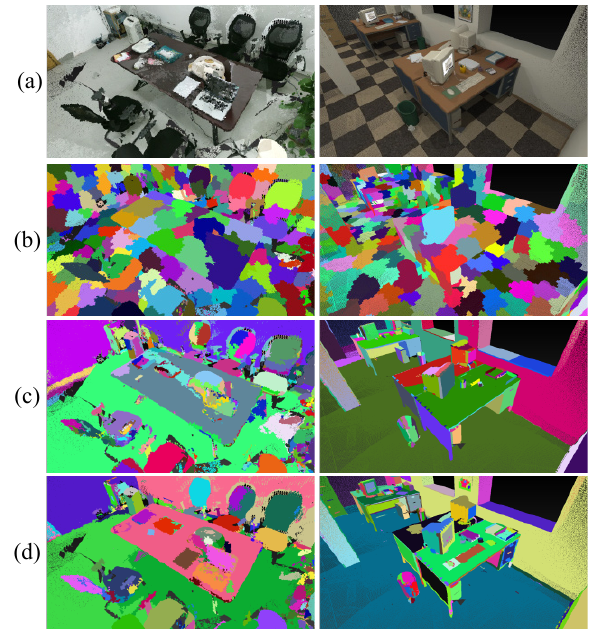
Fig. 4 Patch construction results. (a) Downsampled point clouds from different datasets. (b) By Ref. [7]. (c) By Ref. [24]. (d) Our